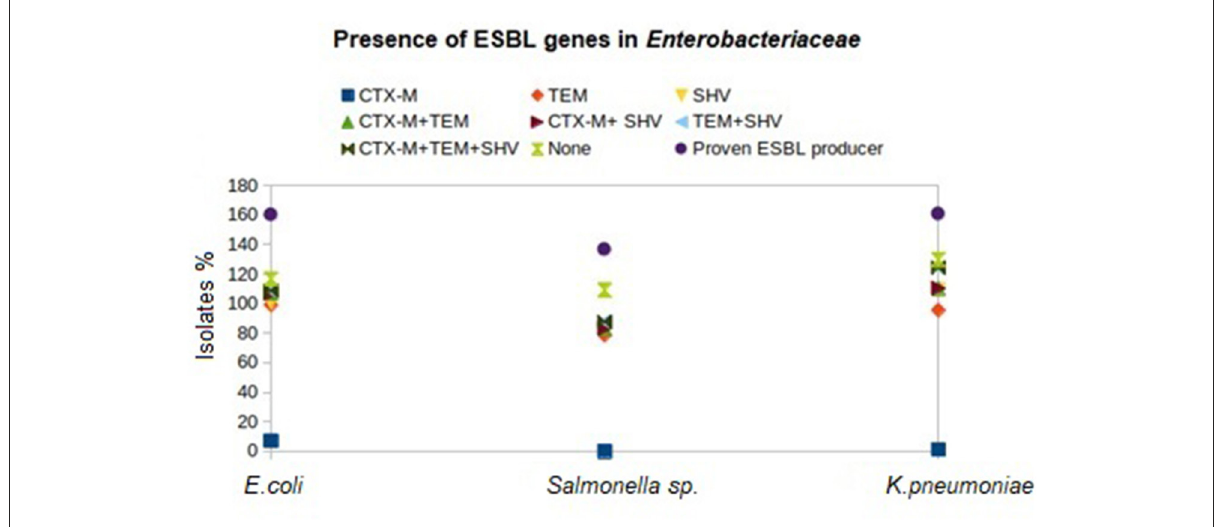
FIGURE2 Distribution of β -lactamase genes in different birds reared in Andaman and Nicobar Islands